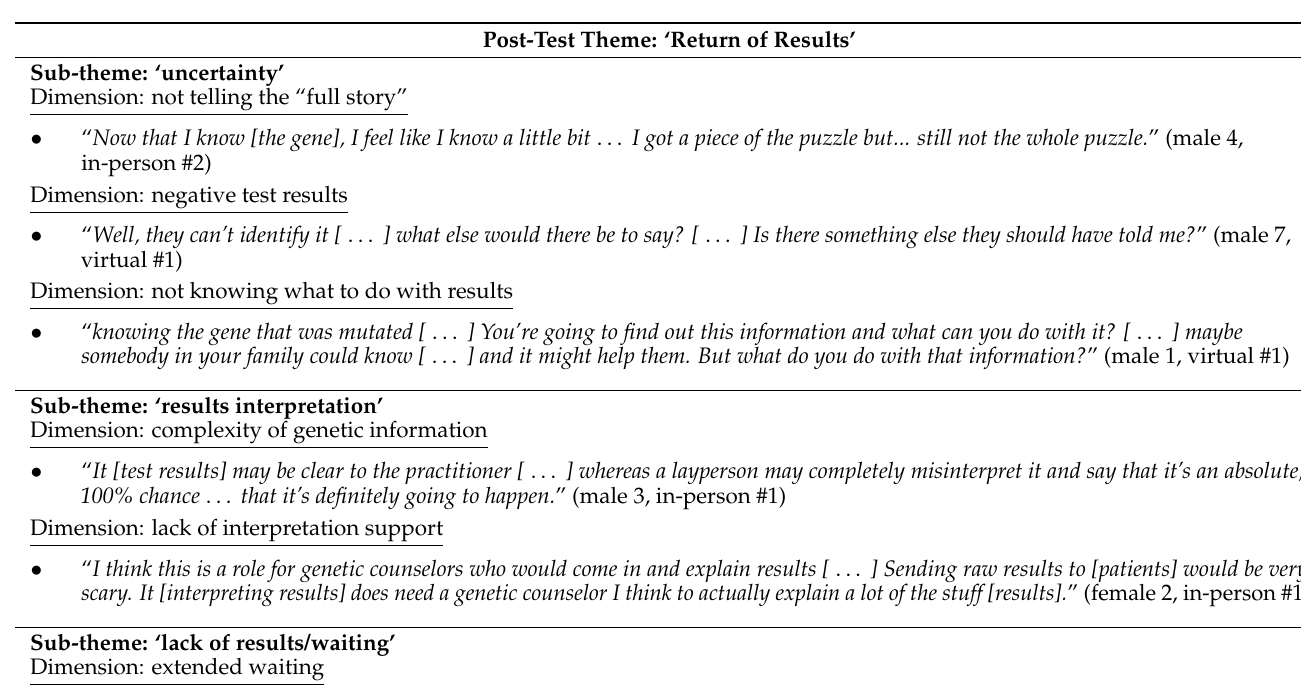
Table 4. Representative quotes relating to post-test experiences: ‘return of